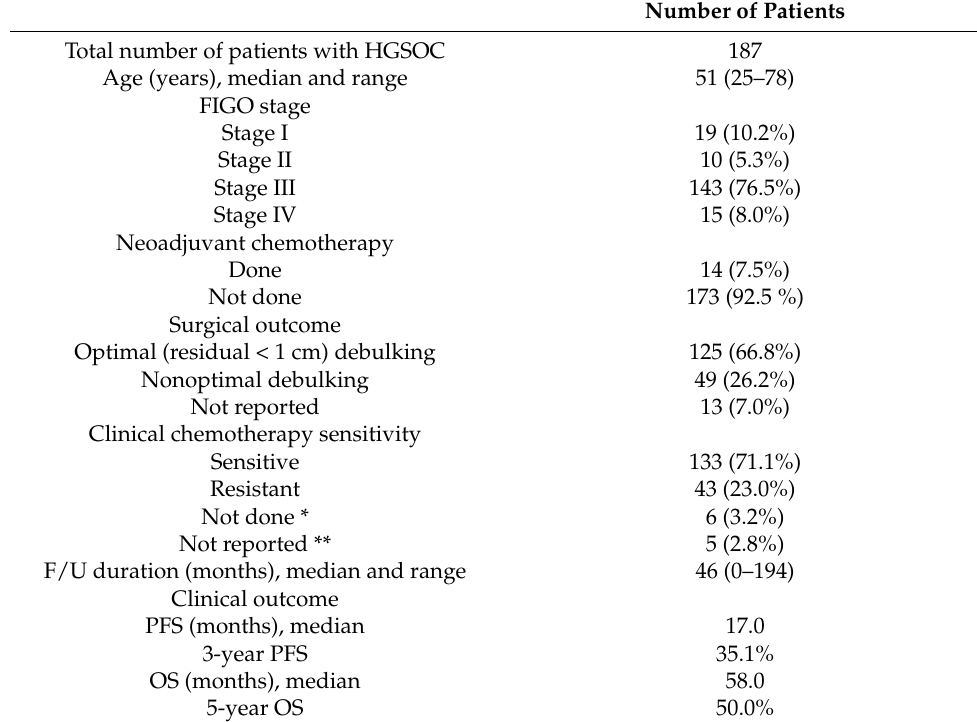
Table 2. Clinical and demographic characteristics of the